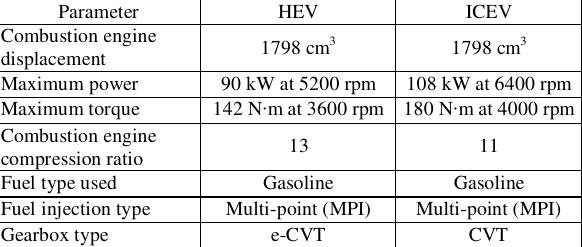
Table 1. Specifications of the vehicles